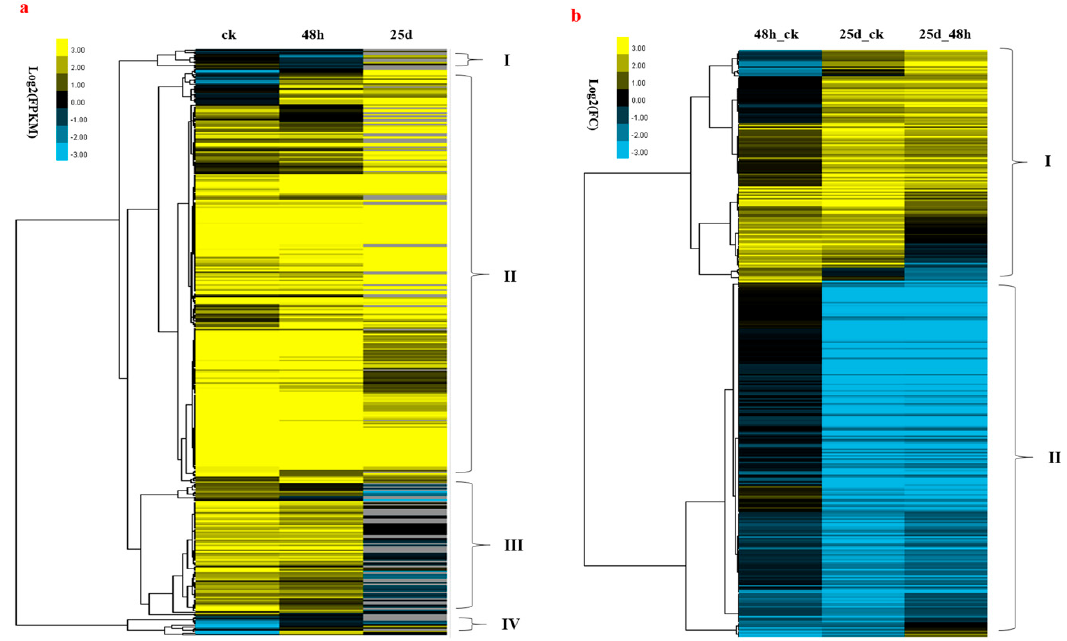
Figure 10. Hierarchical clustering of expression profiles for 362 differentially expressed DMGs among three libraries. ( a ) The log 2 (Fragments Per Kilobase of exon per Million reads) for ck, 48 hpi, and 25 dpi libraries; ( b ) the log 2 (FoldChange) for 48h_ck, 25d_ck, and 25d_48h. The trees were generated using the Cluster 3.0 (https: // www.encodeproject.org / software / cluster / ) and Java Treeview (http: // jtreeview.sourceforge.net /